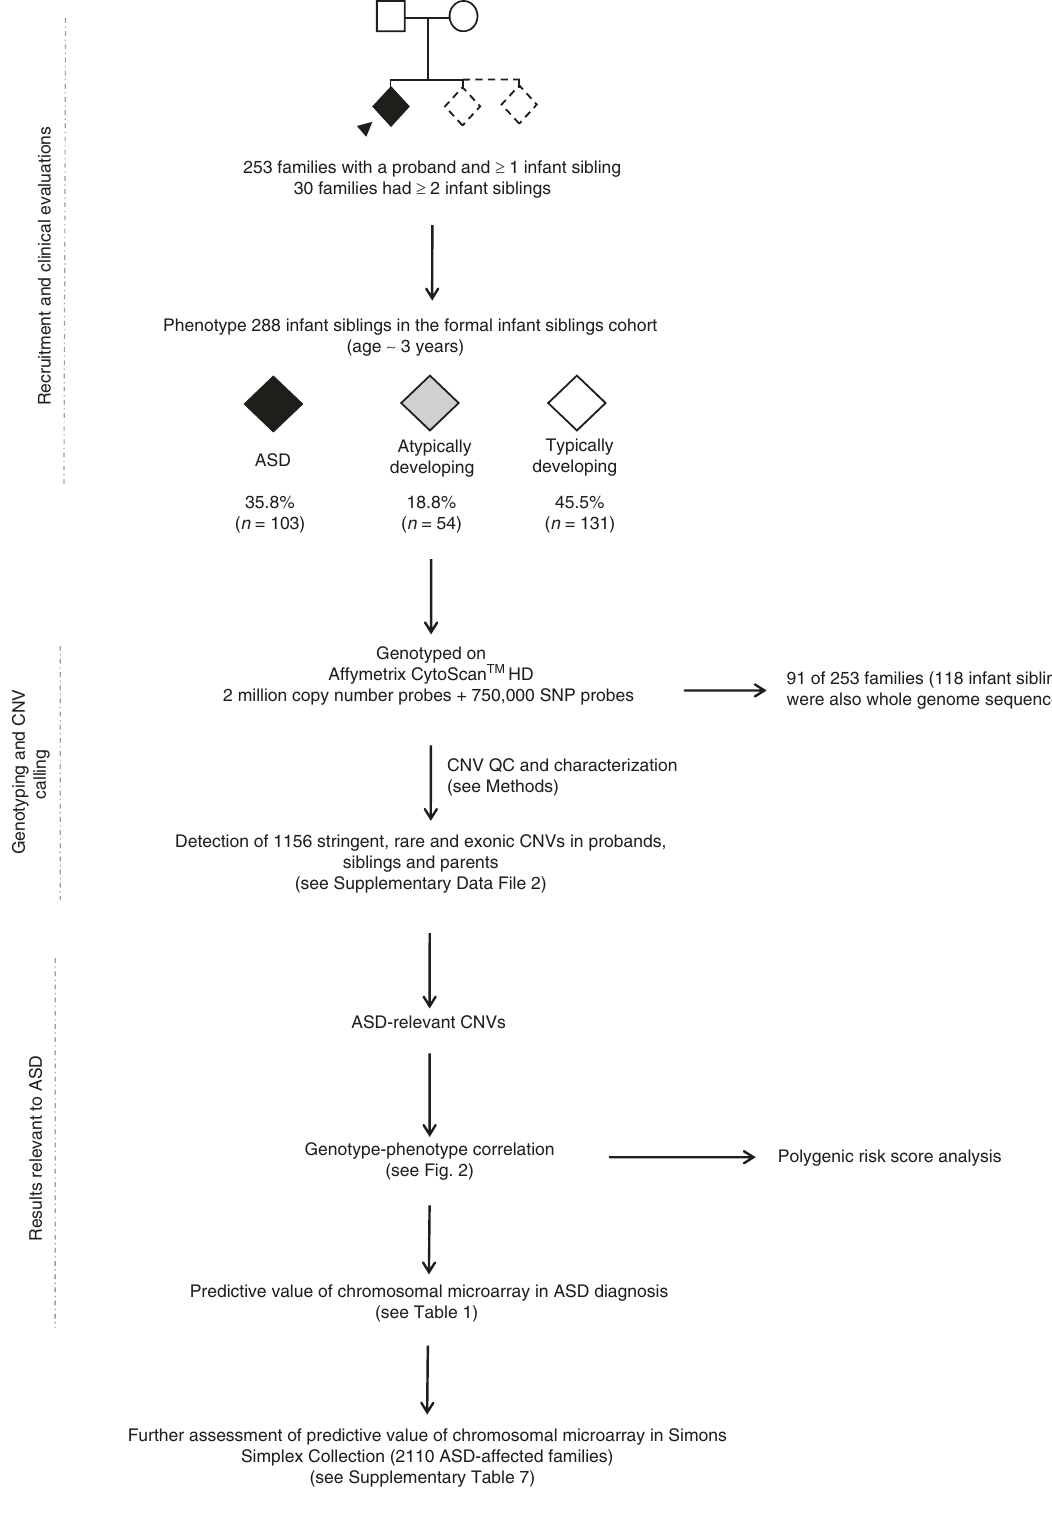
6.6:1 male to female ratio for probands) 33 . Of the SSC “ unaffected ” sibs, applying similar criteria as for the BSRC cohort revealed 288 (11.9%) with atypical behavioral and developmental pro fi les: 33 were suspected to have elevated ASD traits (Social Responsiveness Scale-Parent Report Total T -Score > 60 34 ); 139 had emotional and behavioral problems (Child Behavioral Checklist-Parent Report Total Problems T -Score > 60 35 ); 65 displayed